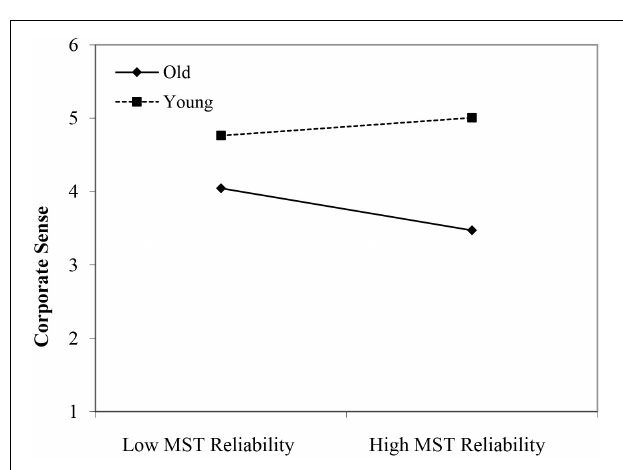
FIGURE 10 | Interaction between perceived age-based (meta-)stereotyping adaptability and age groups: Predicting corporate sense. Low = –1 SD